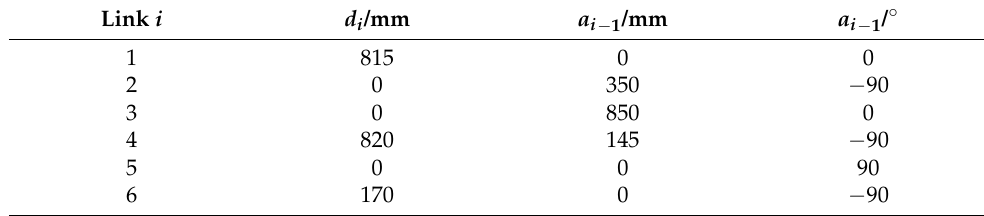
Table 1. DHm parameterization of KUKA